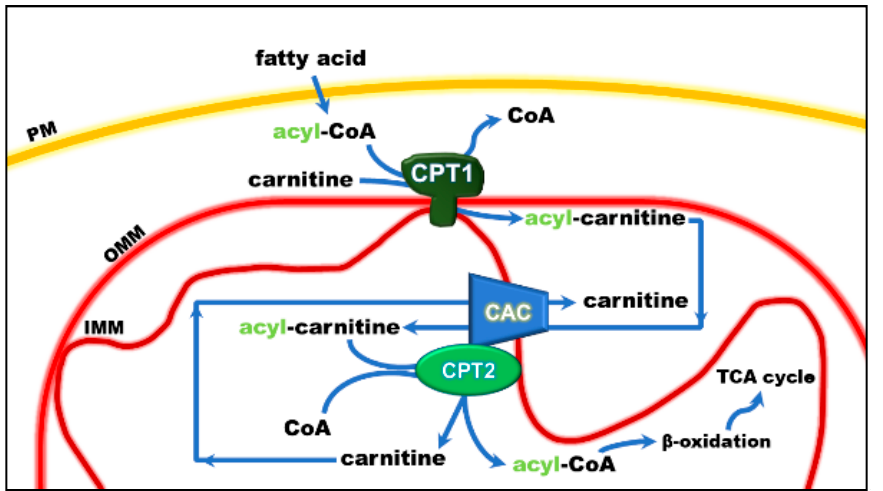
Figure 1. Role of the carnitine shuttle in the mitochondrial β -oxidation pathway. The shuttle is constituted by carnitine palmitoyltransferase 1 (CPT1) that converts acyl-CoAs into acyl-carnitines; carnitine/acyl-carnitine carrier (CAC) that allows the uptake of acyl-carnitines in the mitochondrial matrix in exchange with free carnitine, and carnitine palmitoyltransferase 2 (CPT2) that converts acyl-carnitines back to acyl-CoAs and releases free carnitine, which is ready to be translocated back to the cytosol by CAC. Once in the matrix, acyl-CoA undergoes β -oxidation with the production of acetyl-CoA that enters the tricarboxylic acid cycle (TCA). Other abbreviations: IMM, inner mitochondrial membrane; OMM, outer mitochondrial membrane; PM, plasma membrane.